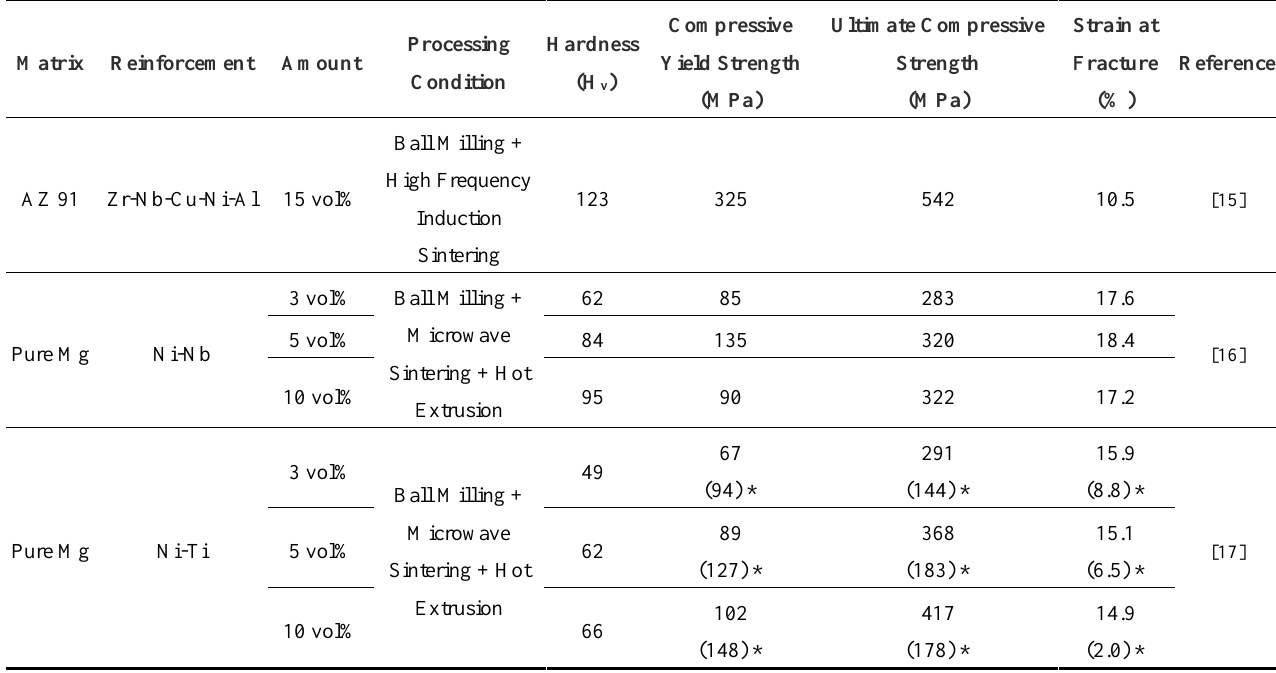
Table 2. Properties of BMG reinforced